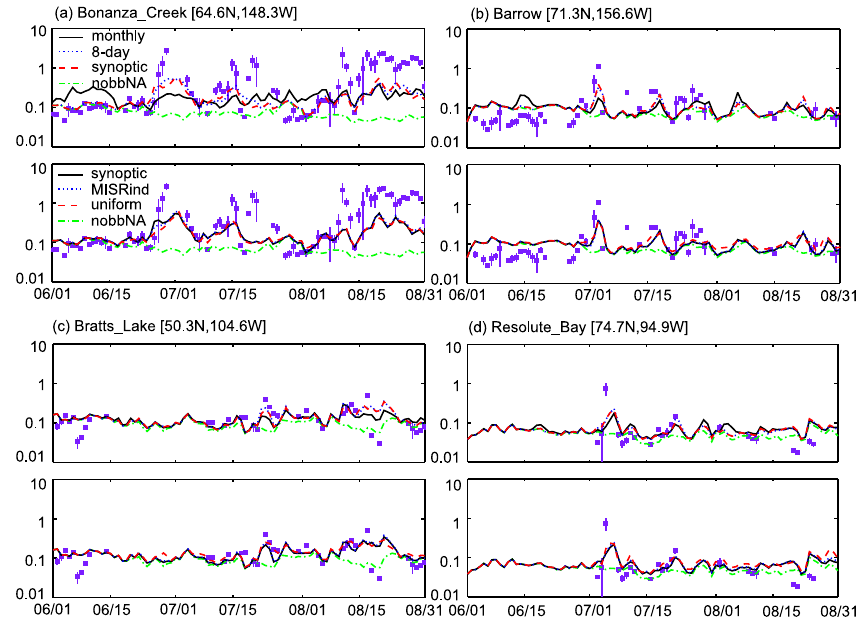
Fig. 13. Time series of 500nm AOD from model simulations and AERONET observations. Daily mean values and uncertainty ranges of AERONET data are shown in filled square boxes and vertical bars. Upper panel for each site shows the sensitivity to temporal constraints. Bottom panel for each site shows the sensitivity to injection